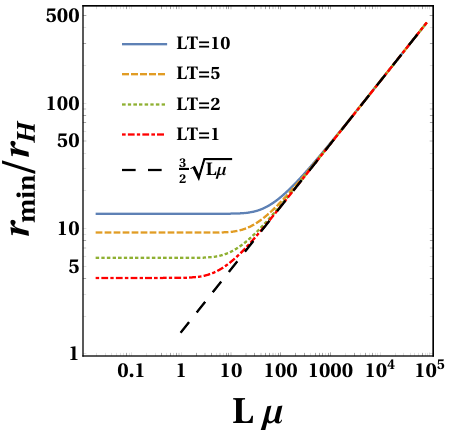
Figure 5 . The minimum of the e(cid:11)ective potential at (cid:12)xed temperature and with the D3-brane q 3 charge (cid:12)xed to Q D3 = 9 t 3 (cid:31) 3 as in (4.18). We have chosen to present the curves for (cid:31) 3 = 1 and 0 4 (cid:25) 2 2 LT = 10 ; 5 ; 2 ; 1 (top-down). The dashed black line is the analytic result r min for the gap in the large R -charge limit. Notice that the gap goes to a (cid:12)nite value in the opposite limit of small R -charge, in precise agreement with solving (4.25)